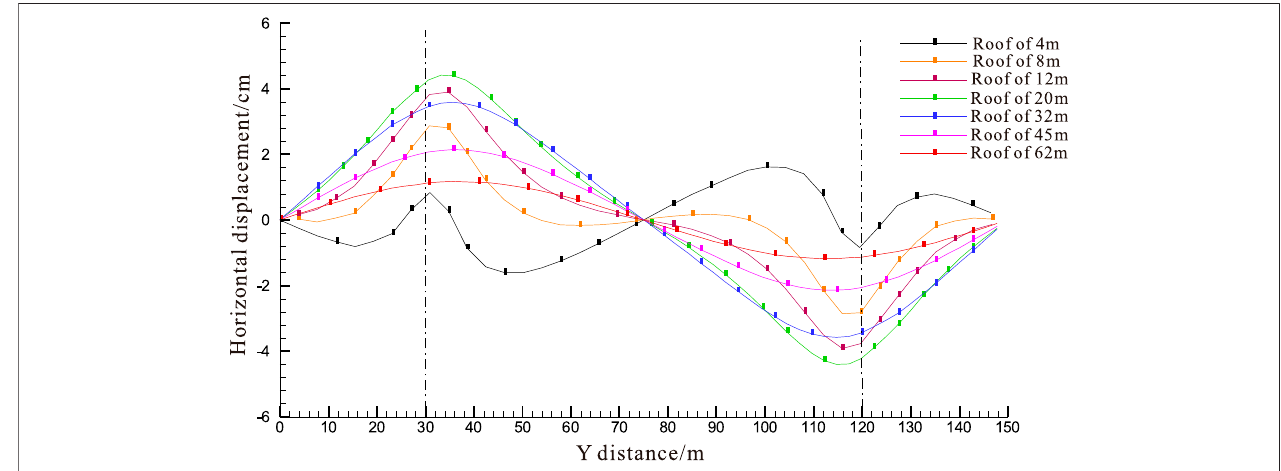
Frontiers in Earth Science |